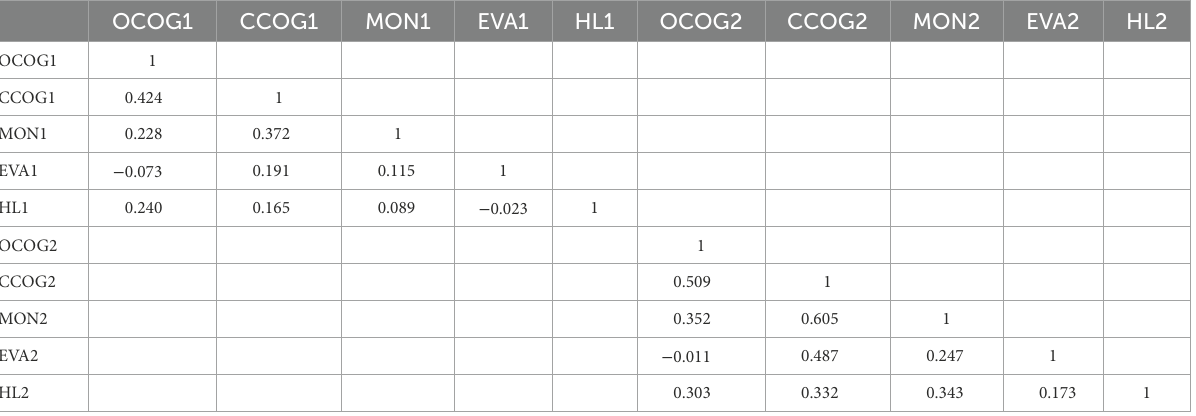
TABLE 3 Factor correlation matrix of CFA.